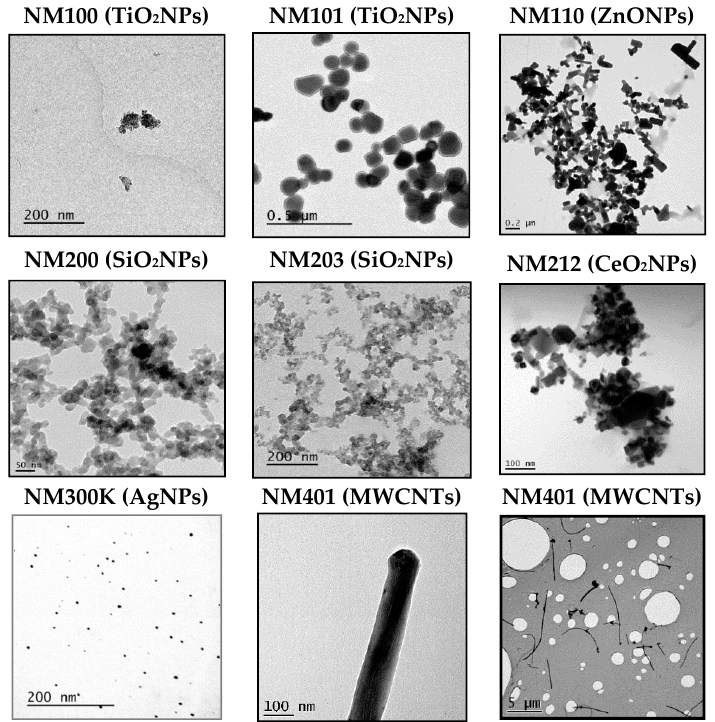
Figure 1. Representative TEM images of the eight used nanoparticles (NPs). Figures correspond to TiO 2 NPs (NM100), TiO 2 NPs (NM101), ZnONPs (NM110), SiO 2 NPs (NM200), SiO 2 NPs (NM203), CeO 2 NPs (NM212), AgNPs (NM300K), and MWCNT (NM401). For NM401 two images are include to visualize their length and